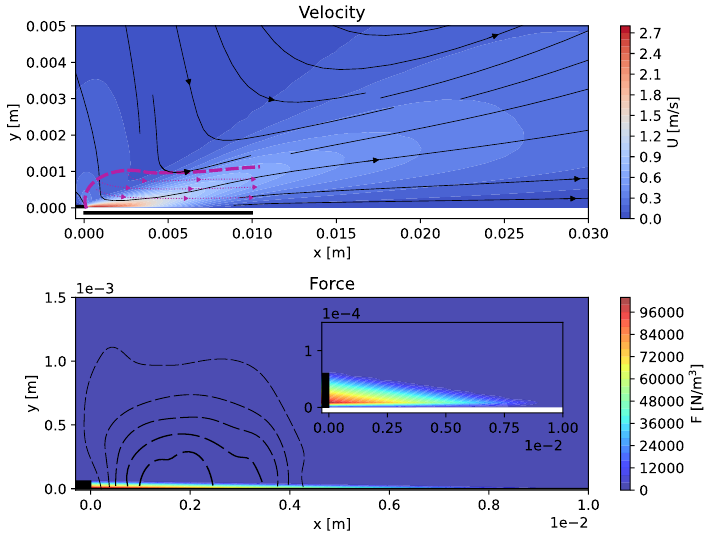
Figure 6. Modified Shyy model velocity field ( top ) and force ( bottom ) at 12 kV and 2 kHz. Purple lines and arrows are the reference wall jet, black arrows are the streamlines of the numerical